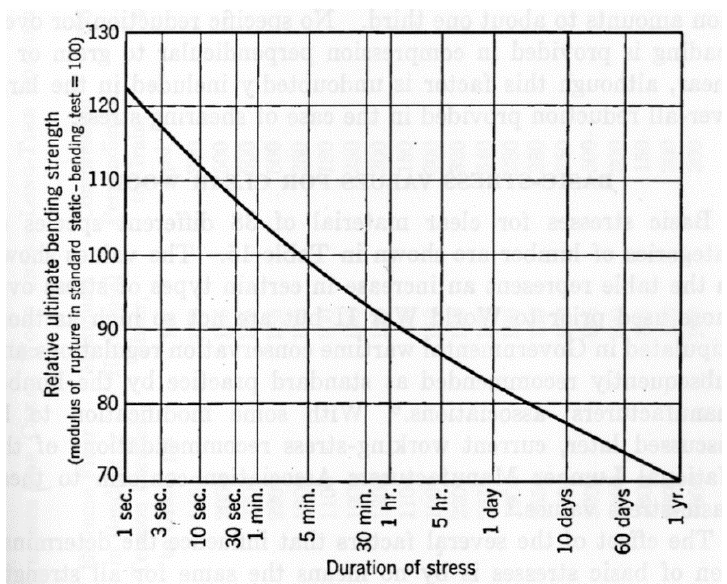
Figure 24. Variation in ultimate bending strength with duration of stress (time between initial application of load and failure) for unseasoned clear-wood Sitka Spruce ( Picea sitchensis ). From [112].